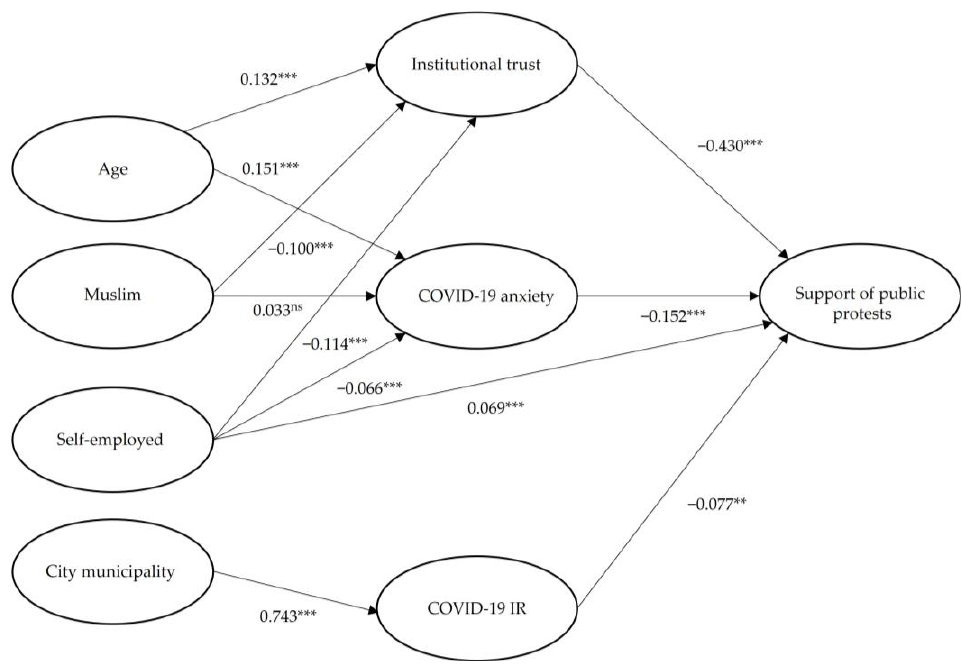
Figure 2. Structural equation model with standardized effects. Note: ** p < 0.01, *** p < 0.001, ns: not significant at the 5% significance level (two-tailed).